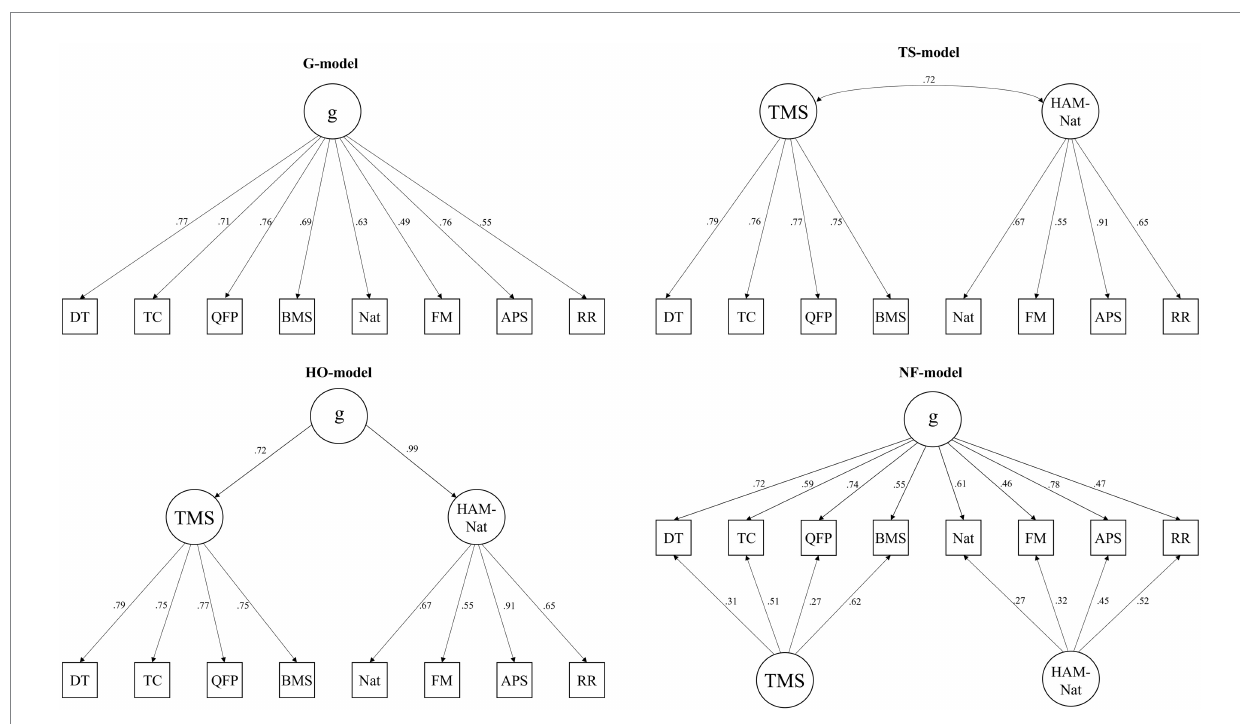
FIGURE 1 Confirmatory factor analyses for alternative models estimating general and specific factors of both admission tests.